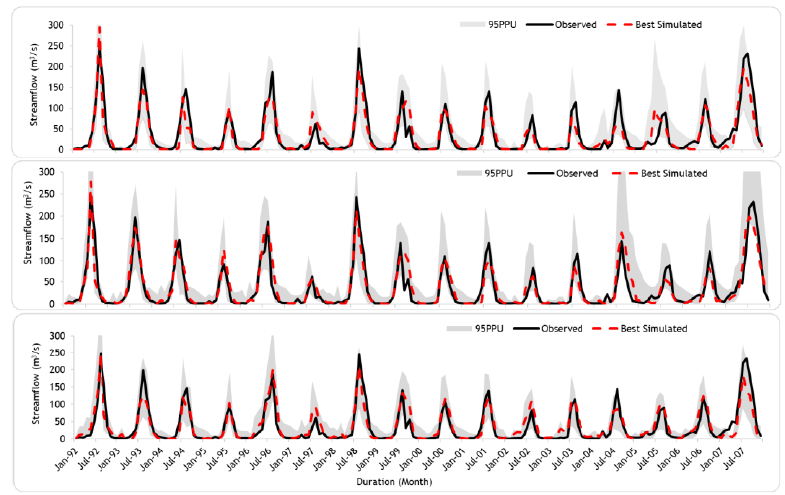
Figure 9. Top-down orientation of observed and best-simulated flows with their 95% confidence level of the subbasin segmentations of 3, 3, and 23, respectively, at the Gecha watershed.